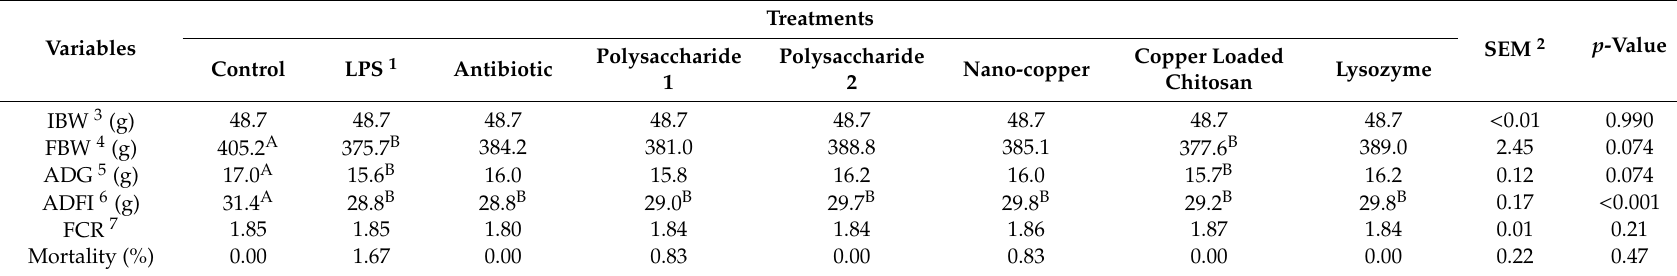
Table 3. E ff ects of mushroom polysaccharide, nano-copper, copper loaded chitosan, and lysozyme on growth performance of yellow-feathered chickens challenged with lipopolysaccharides (LPS).